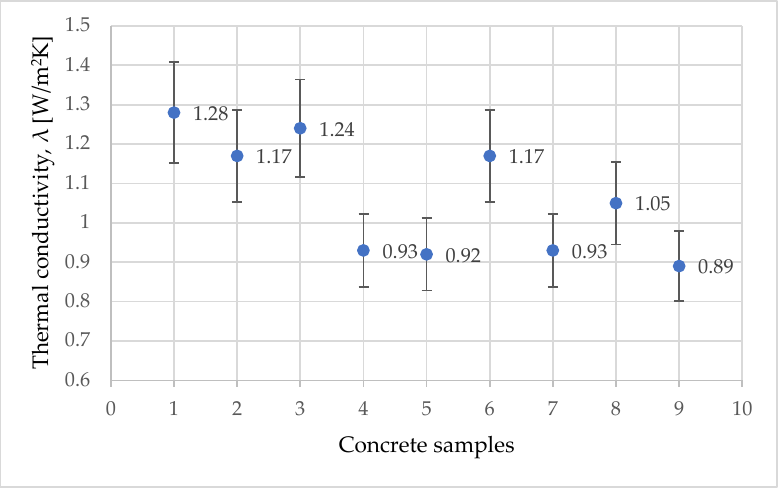
Figure 10 . Variation of thermal conductivity . Figure 10. Variation of thermal conductivity.